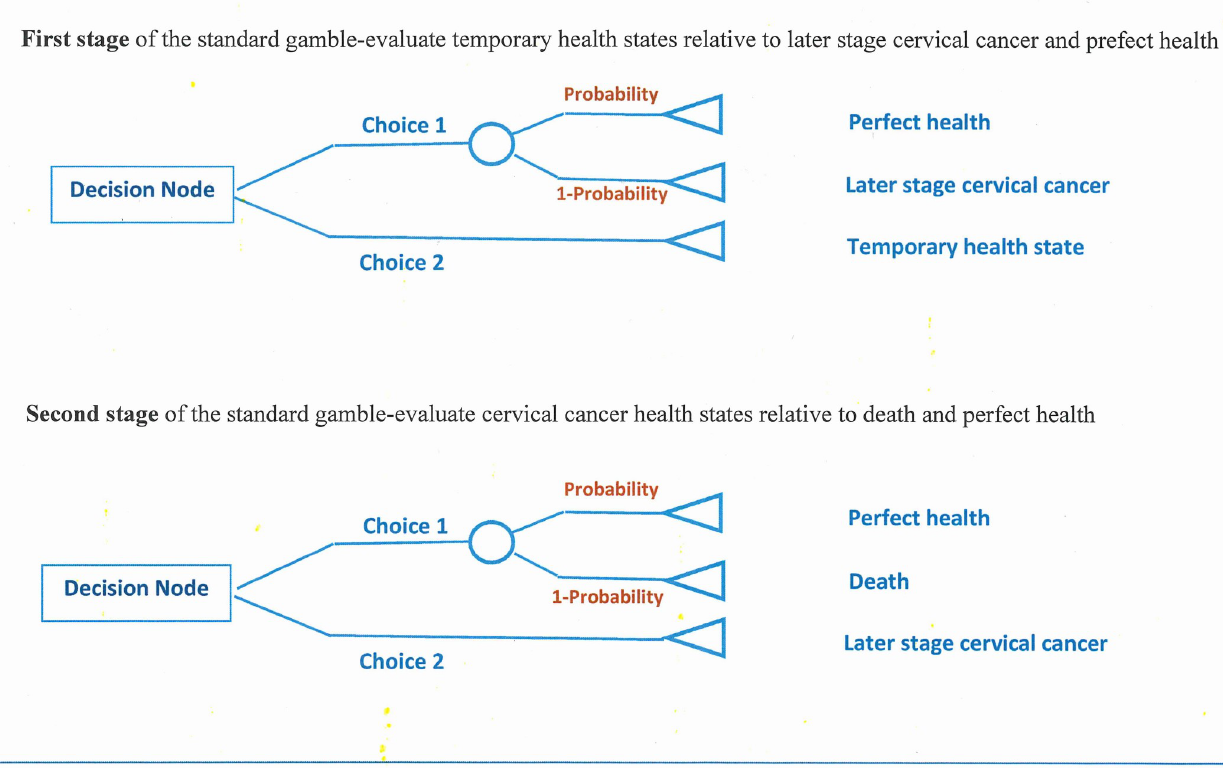
Fig 1. Decision tree of two-stage standard gamble